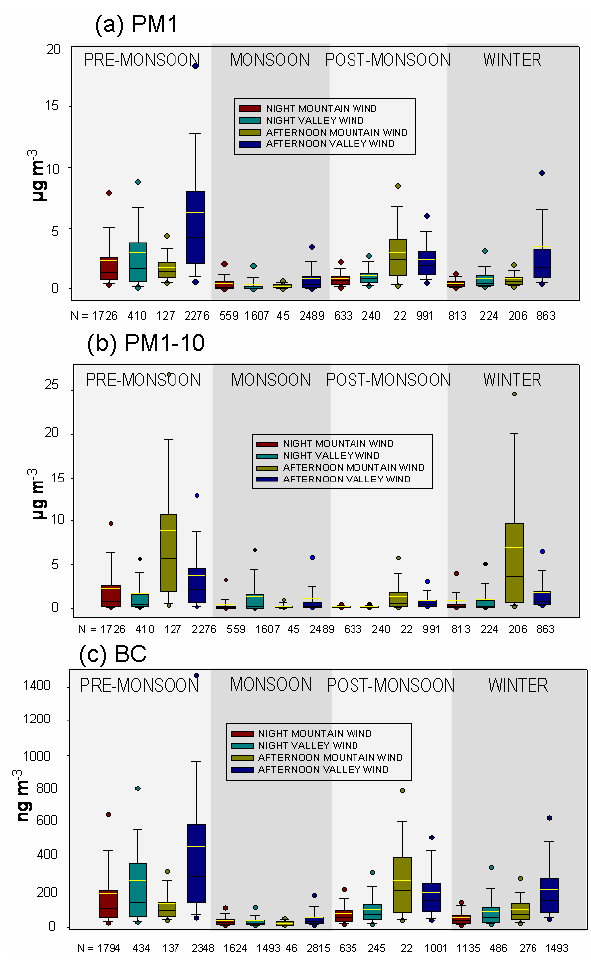
Figure 5. PM1 (a), PM1-10 (b) and BC (c) at NCO-P in function of wind direction during Fig. 5. PM 1 (a) , PM 1 − 10 (b) and BC (c) at NCO-P in function nigh-time (00:00 – 06:00) and during afternoon (12:00 – 18:00). The numbers reported on the of wind direction during nigh-time (00:00–06:00) and during after- x-axis specify the number of averaged 30-min values noon (12:00–18:00). The numbers reported on the x-axis specify the number of averaged 30-min